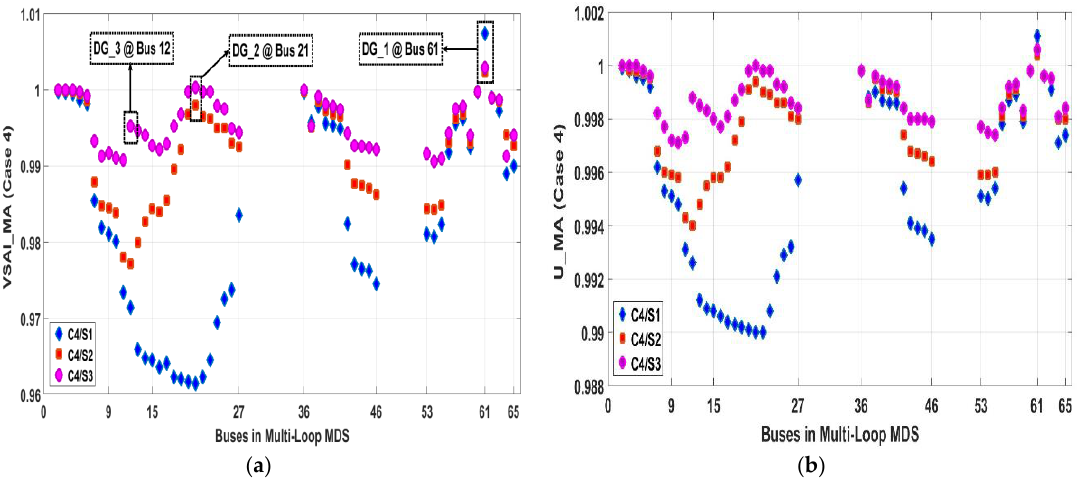
Figure 18. Case 4 for 69-bus MDS L_Min ( a ) VSAI trend (based on ideal MDS) for VSAI_MA-LMC; and ( b ) U-profile trend for VSAI_MA-LMC, based planning approach (DG @ pf = 0.82 ± 2.5%).